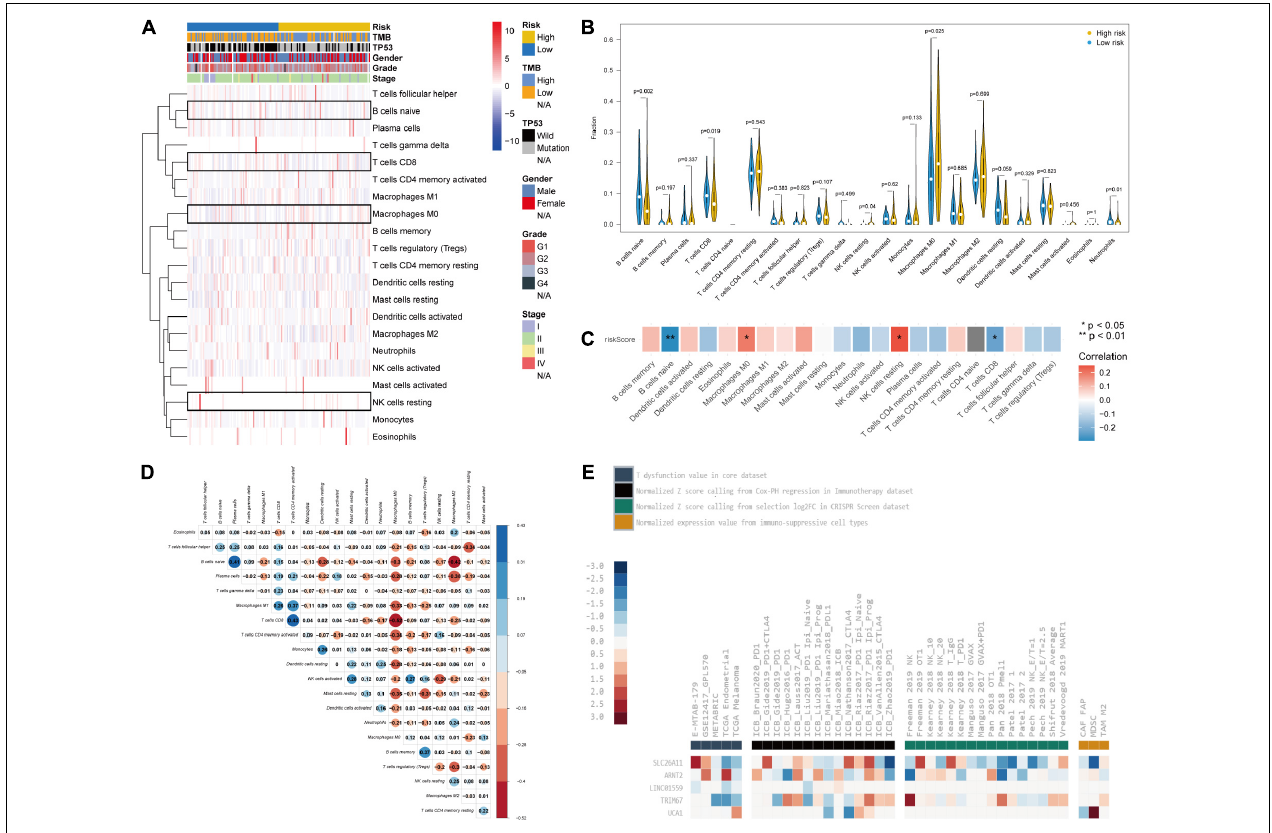
FIGURE 6 | The characteristics of immune cell infiltration and correlation with the TP53-associated signature. (A) Immune cell heatmap and clinicopathological characteristics of two phenotypes defined by TP53-associated signature. Four kinds of immune cells were highlighted with boxes. (B) Violin plots reflecting the differential composition of 24 types of tumor-infiltrating immune cells. (C) Correlation matrix visualizing the relationship between tumor-infiltrating immune cells and risk scores based on the TP53-associated signature. (D) Mutual correlations between 24 types of tumor-infiltrating immune cells. (E) The role of the five genes in T cell dysfunction, prognosis after immune checkpoint blockade (ICB) therapy, and immunosuppressive T cell